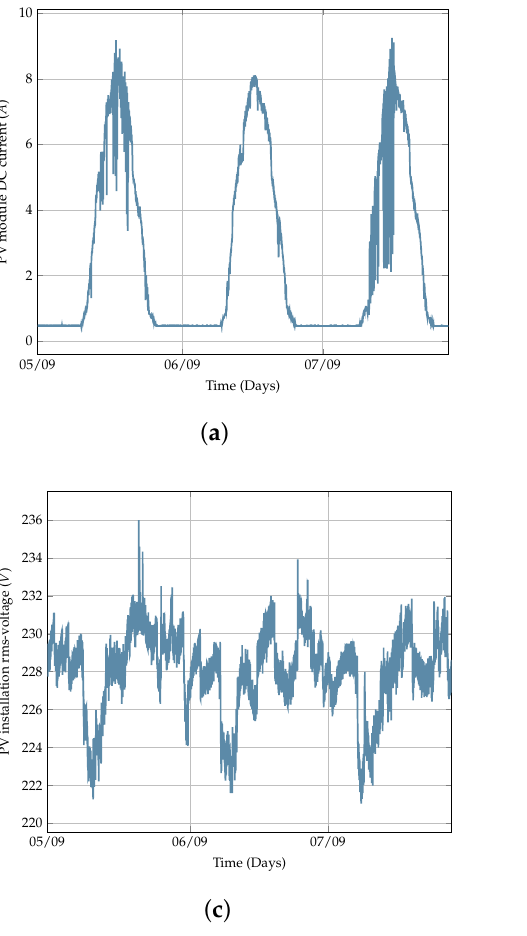
Figure 12. PV installation connected to the grid: AC and DC electrical variables: ( a ) PV module DC current; ( b ) PV installation DC current; ( c ) PV installation AC voltage (rms); and ( d ) PV installation AC current